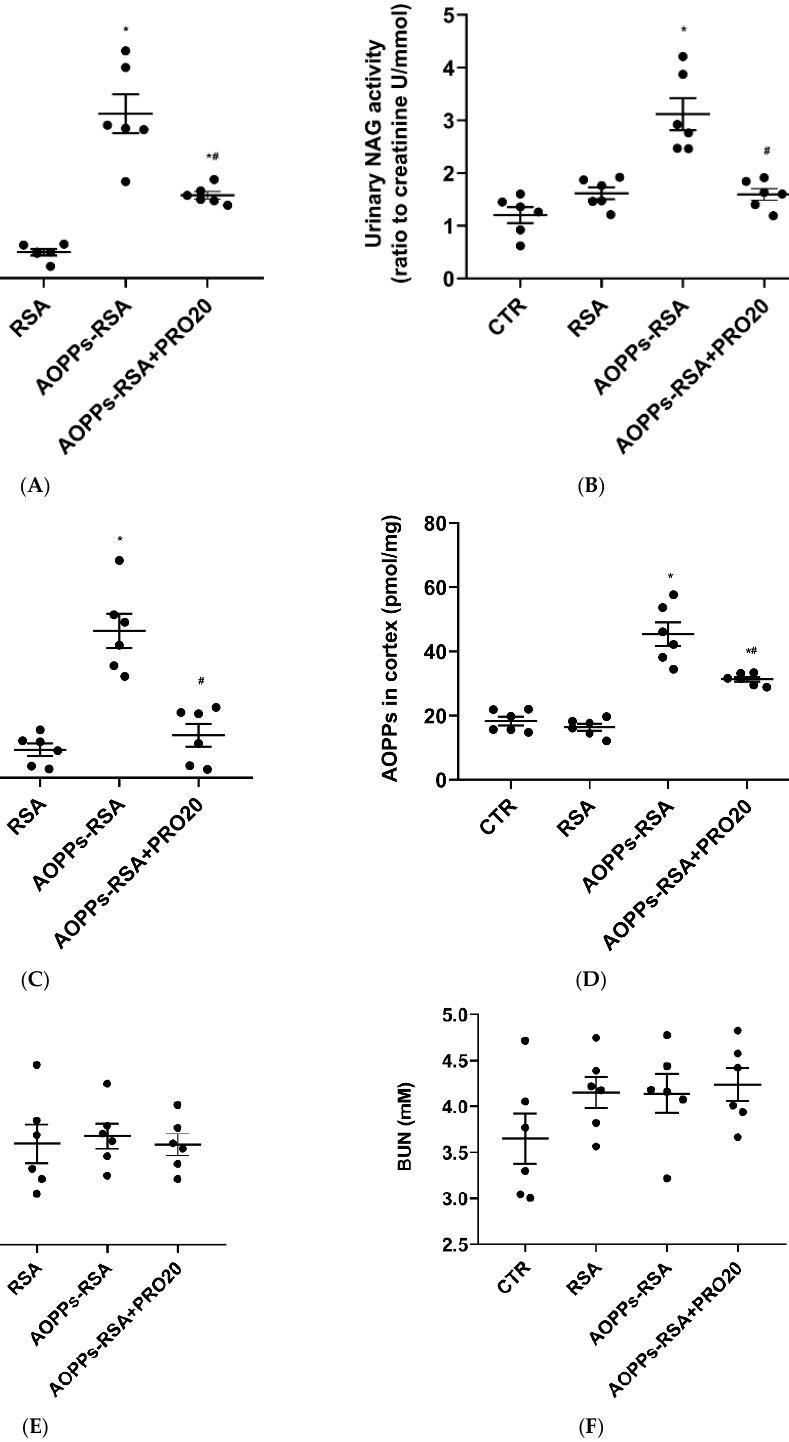
Figure 2. Effects of PRO20 on albuminuria ( A ), urinary NAG activity ( B ), AOPPs in plasma ( C ), AOPPs in renal cortex ( D ), pCr ( E ), and plasma BUN ( F ). Notes: NAG, N-acetyl- β -d-Glucosaminidase; pCr, plasma creatinine; BUN, blood urea nitrogen. The results are presented as means ± SEM. There were 6 rats per group. * p < 0.05, compared to the CTR group; # p < 0.05, compared to AOPPs-RSA